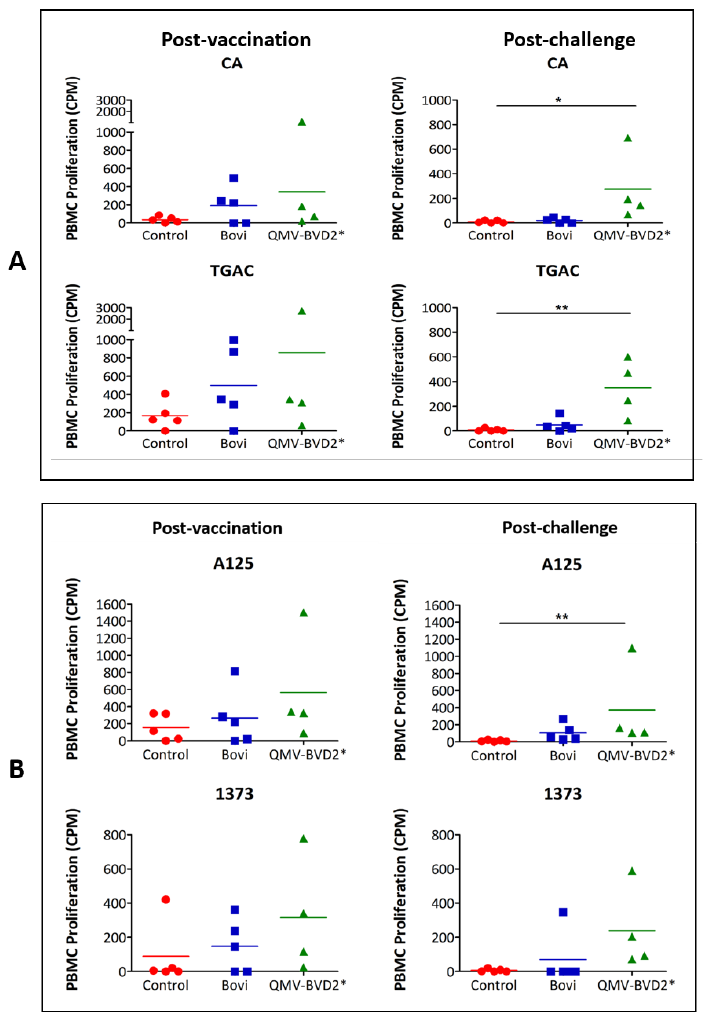
Figure 7. Post–vaccination and post–challenge BVDV–1 ( A ) and BVDV–2 ( B ) strain–specific